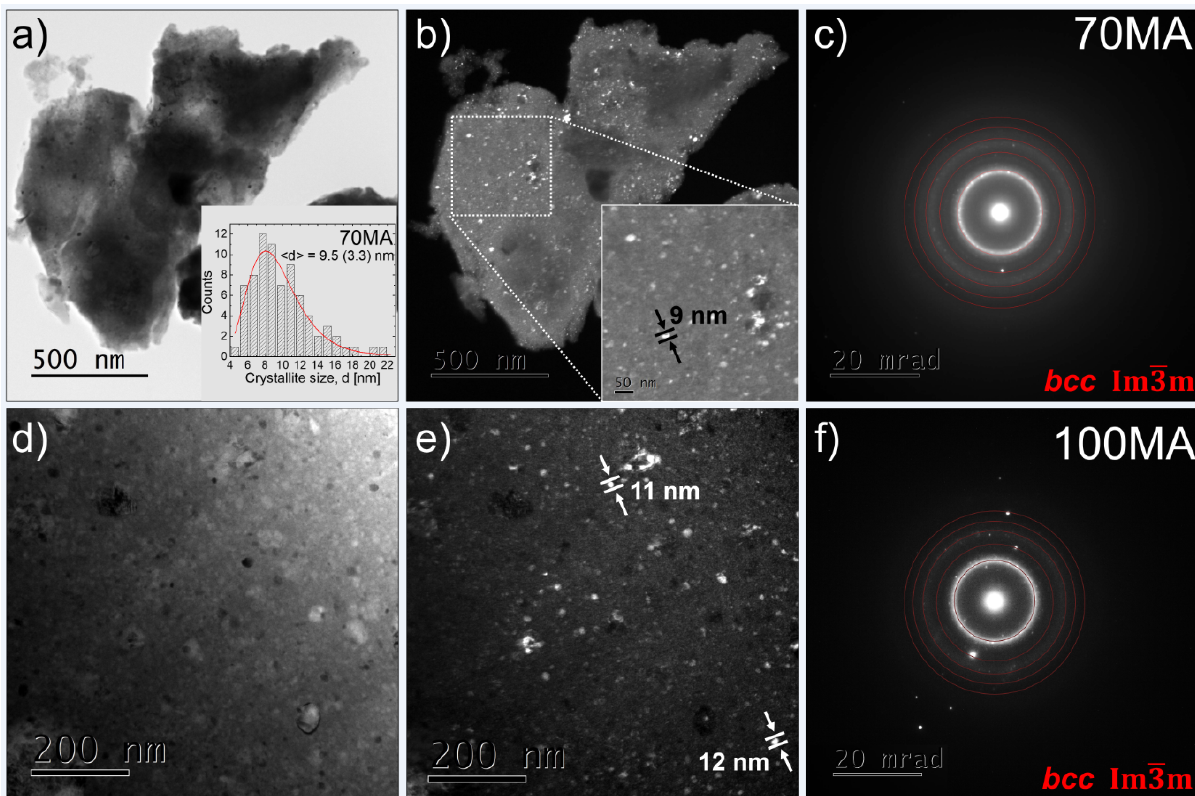
Figure 3. TEM results: ( a , d ) bright-field (BF) images, ( b , e ) dark-field (DF) images, ( c , f ) selected area electron diffraction patterns (SAEDP) of the as-milled 70MA and 100MA powders, respectively. The inset in ( a )—histogram of the crystallite size distribution.